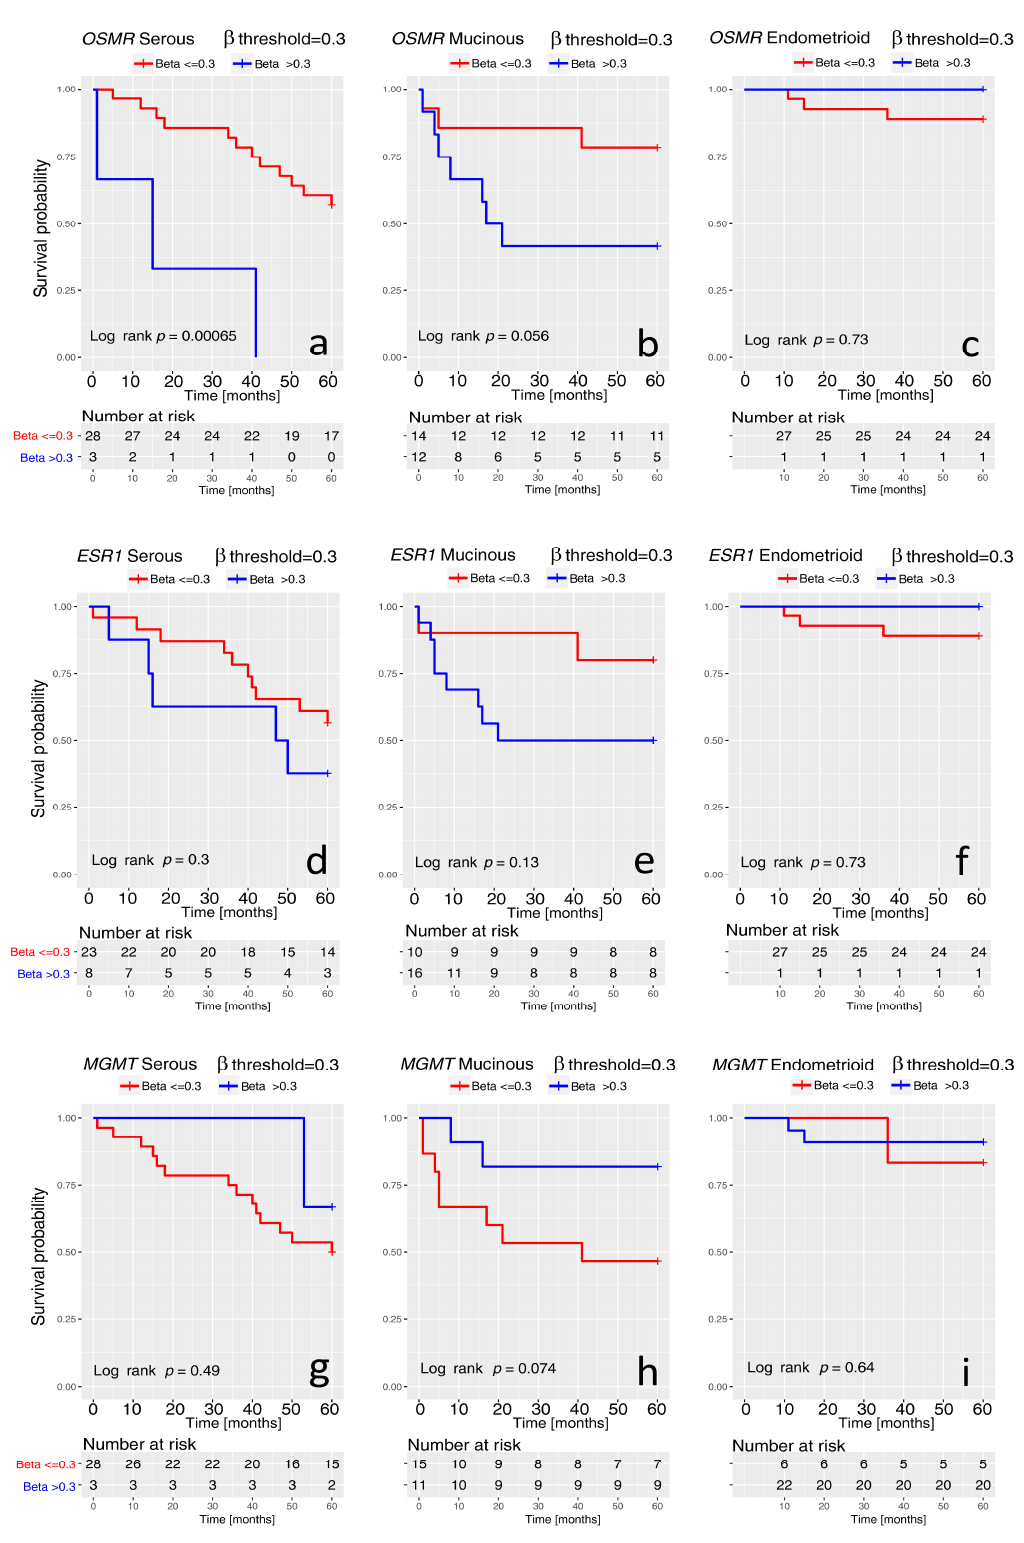
Figure 4. Kaplan-Meier analysis of overall survival of ovarian carcinomas stratified for their histology: S (Serous), M (Mucinous), E (Endometrioid). Curves were generated for OSMR (upper panel) ( a – c ), ESR1 (central panel) ( d – f ), and MGMT (lowest panel) ( g – i ). In each graph, the β threshold and their colors (red, blue) and the p value are reported. The number of patients in each subgroup is reported in the table at the bottom of each graph. The censored cases are marked by “+”.